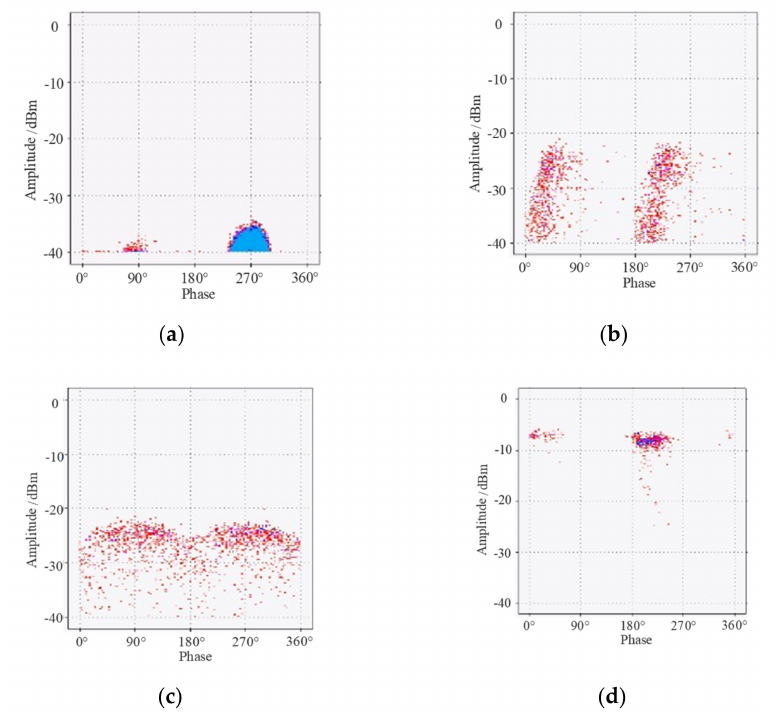
Figure 1. PRPD data of different PD types. ( a ) tip discharge, ( b ) surface discharge, ( c ) air gap discharge, and ( d ) suspended